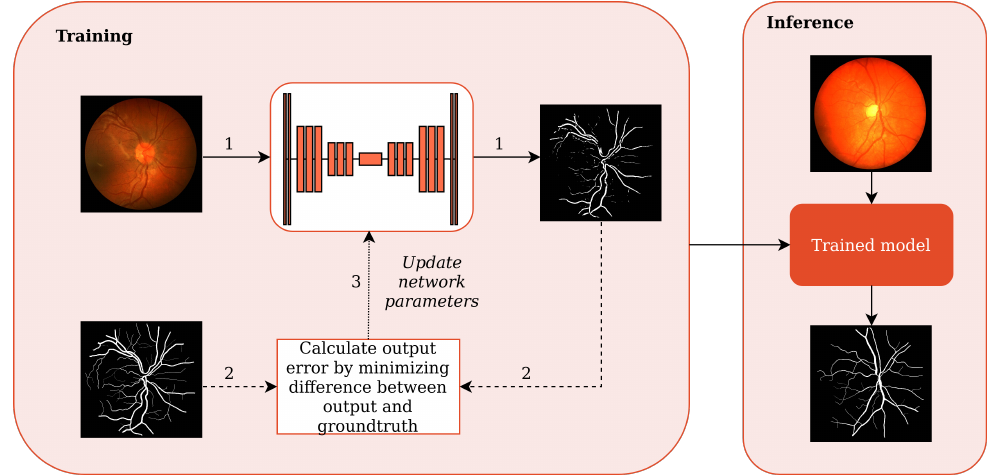
Figure 2. The CNN lifecycle. The training schema shows (1) feeding CNN with training images to obtain predicted outputs, (2) using predicted outputs and ground truth images to update CNN parameters, and (3) updating CNN parameters. In the inference schema, a trained model is fed with unseen images to obtain predictions without the ground truth being